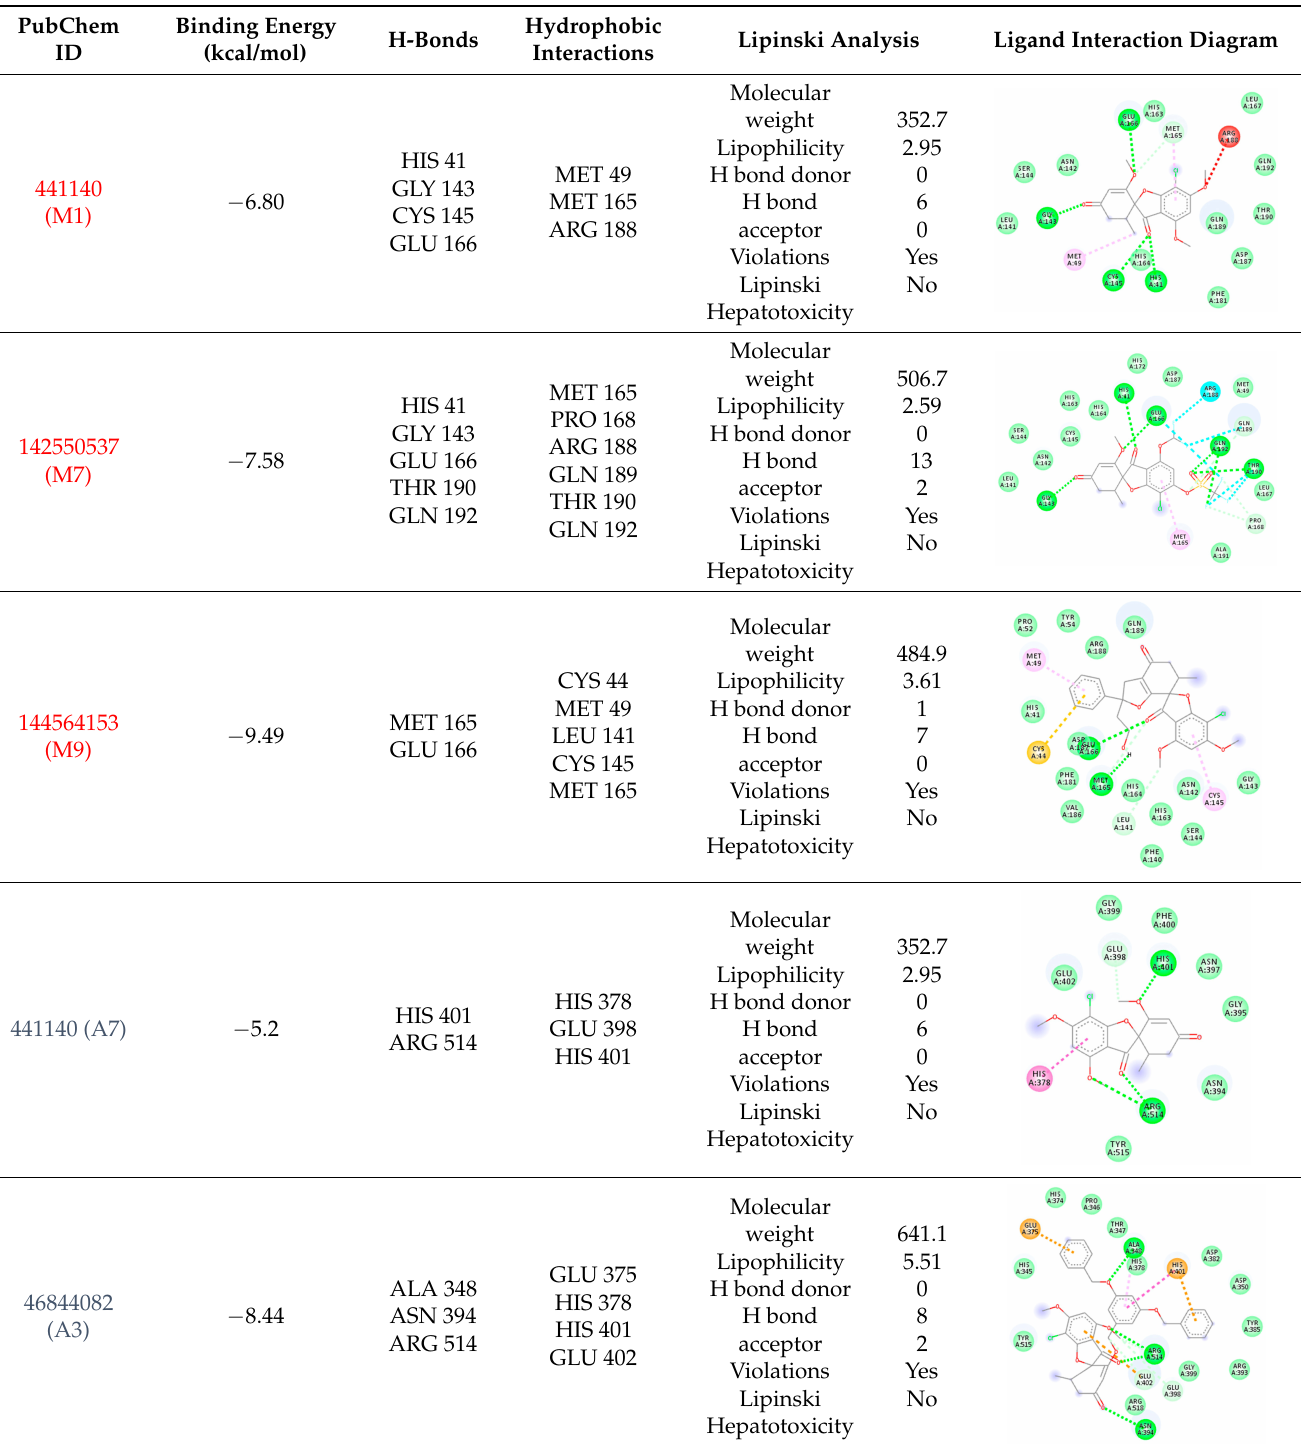
Table 1. Molecular docking details of the top compounds selected for MD analysis. PubChem ID compound (first column), highlighted in red, blue, orange, and green, to indicate their interactions with M protease, ACE2, RdRp, and RBD, respectively. The dotted lines in the ligand interaction diagram (last column) show the key interacting residues the of targeted protein and ligand struc- ture. Moreover, the green, light green, orange, pink, blue, and red dotted lines show conventional hydrogen bonds, van der Waals, cation–anion, pi-alkyl, halogen, and unfavorable acceptor–acceptor interactions,